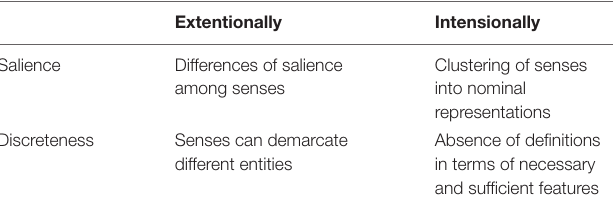
TABLE 1 | Main prototype effects and their mutual